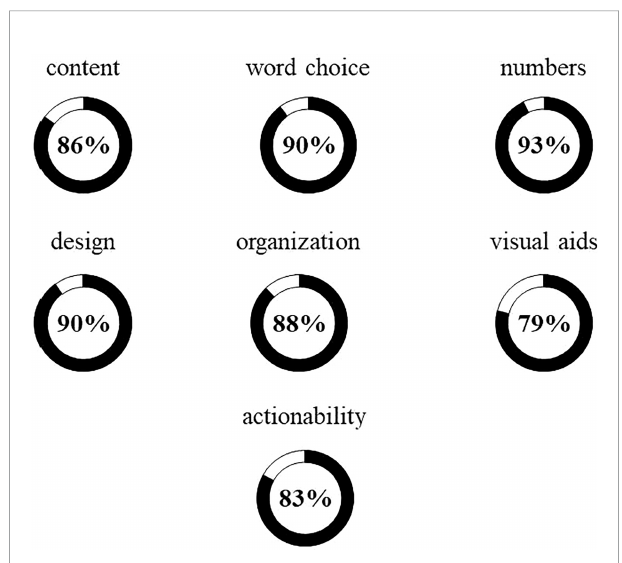
FIGURE 2 | Patient Education Materials Assessment Tool (PEMAT) ratings of KS transition passport understandability and actionability (n=35). The PEMAT includes 17 items within seven domains. Six domains relate to understandability (top two rows) and the other is actionability. Approval ratings are depicted by circle areas in black and percent approval is noted in the center for each domain. Ratings ≥ 80% are considered 'high-quality'. Patient and parent/guardian PEMAT scores did not